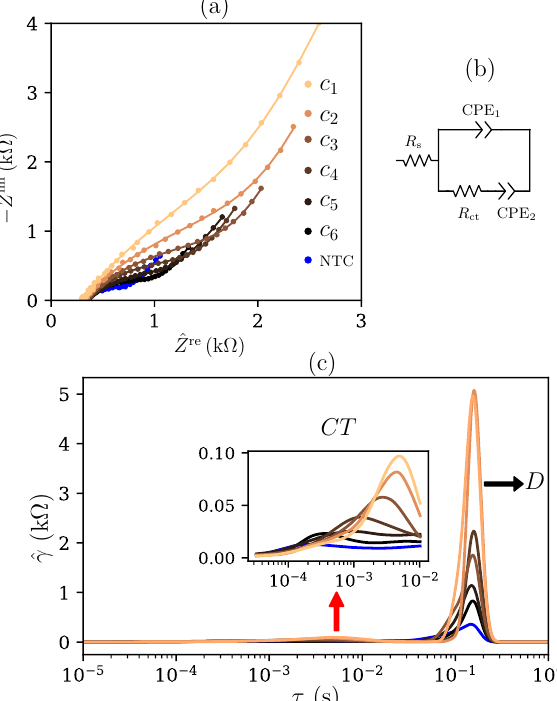
Figure 2. Impedance measurements and time-constant domain spectroscopy for six concentrations of the SARS-CoV-2 genome, c 1 to c 6 . ( a ) EIS measurements in a Nyquist plot after 35 min of the RT-LAMP reaction. ( b ) Equivalent circuit model used for EIS data fitting. ( c ) TCDS retrieved ) by processing EIS data using the DRT model. Two from the estimated distribution function ˆ γ ( · electrochemical processes are highlighted, charge transfer: CT (inset), and diffusion: D